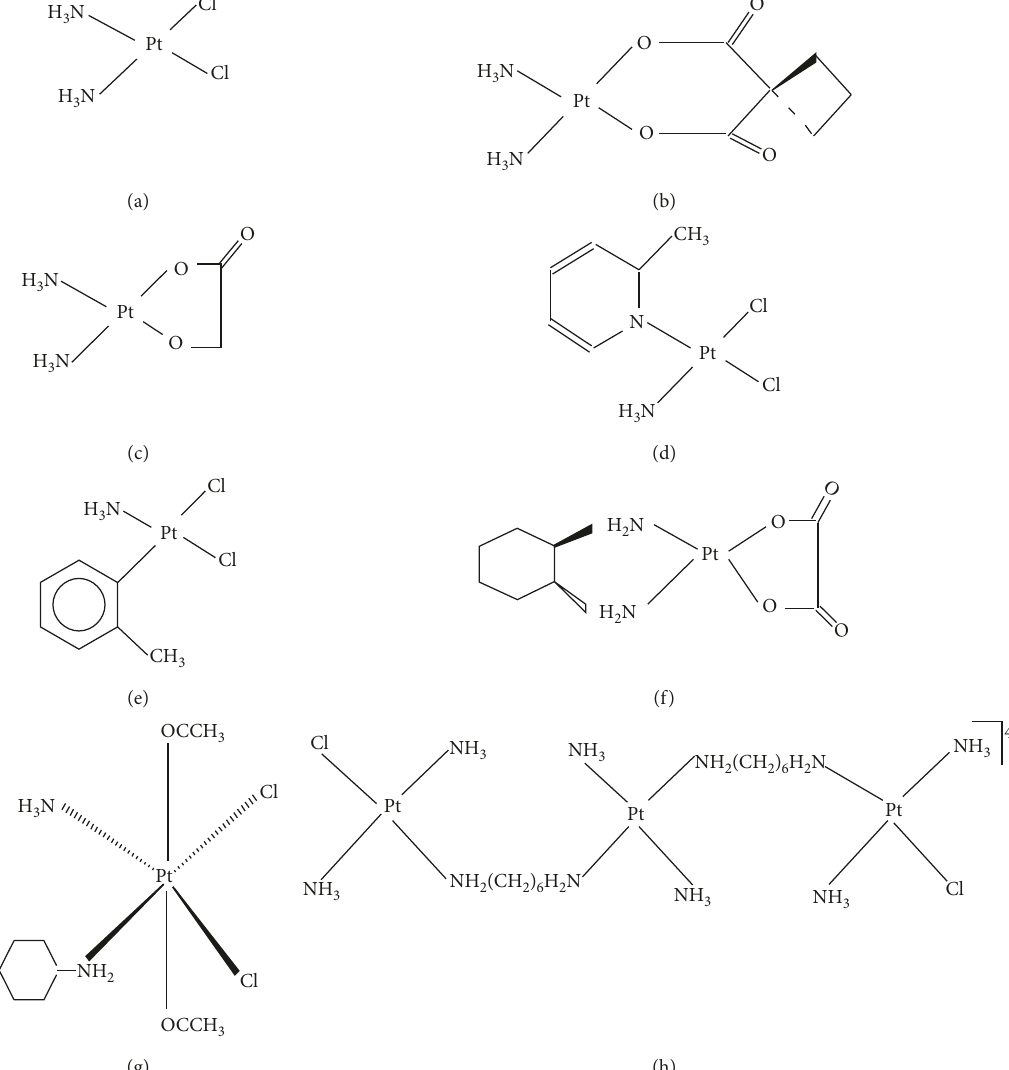
Figure 12: Pt(II) and Pt(IV) anticancer drugs. (a) Cisplatin. (b) Carboplatin. (c) Nedaplatin. (d) ZD0437. (e) AMD473. (f) Oxaliplatin. (g) JM216. (h) BBR3464. Table 1: Antibacterial activities of platinum(IV) dithiocarbamato complexes in μ M. Pt(IV) complex